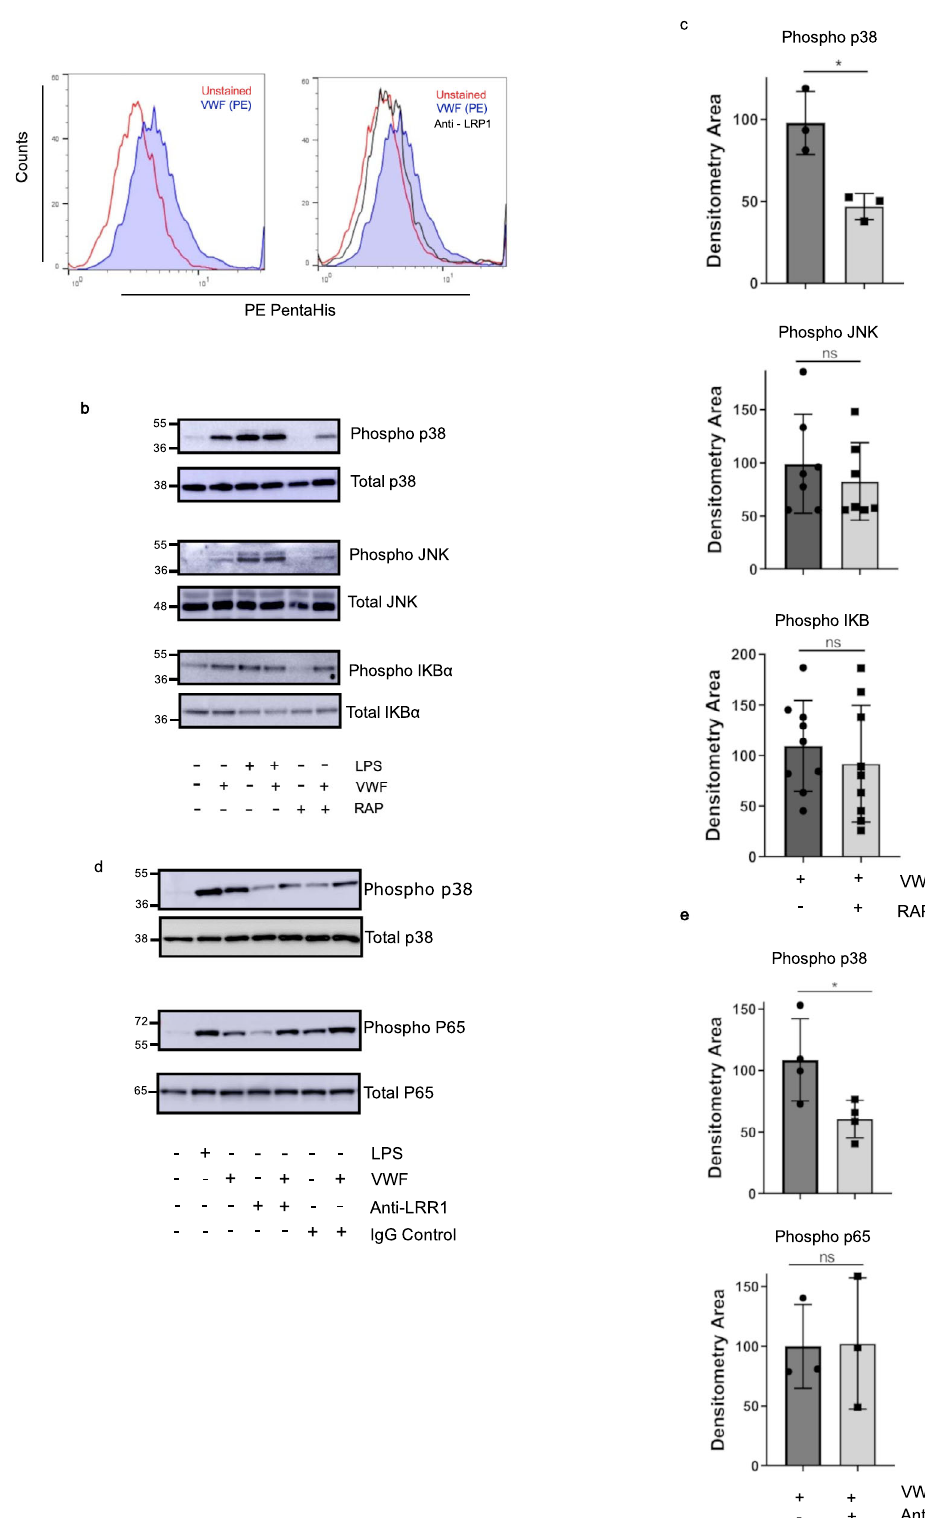
Fig.7|LRP1playsacrucialroleregulatingVWFin fl ammatorysignaling.a Flow cytometry was used to determine the binding of pd-VWF to human primary macrophages in the presence of LRP1 blocking antibody. Flow gating strategy is presented in Supplementary Fig. 14. Representative histogram of VWF bound to macrophage (blue) and pd-VWF bound to macrophage in the pre- sence of anti-LRP1 antibody (black). b Inhibition of human macrophage LRP1 binding with receptor associated protein (RAP) decreased p38 phosphoryla- tion by 50% (* P = 0.013), with no alteration in JNK or NF- κ B activation (ns= not